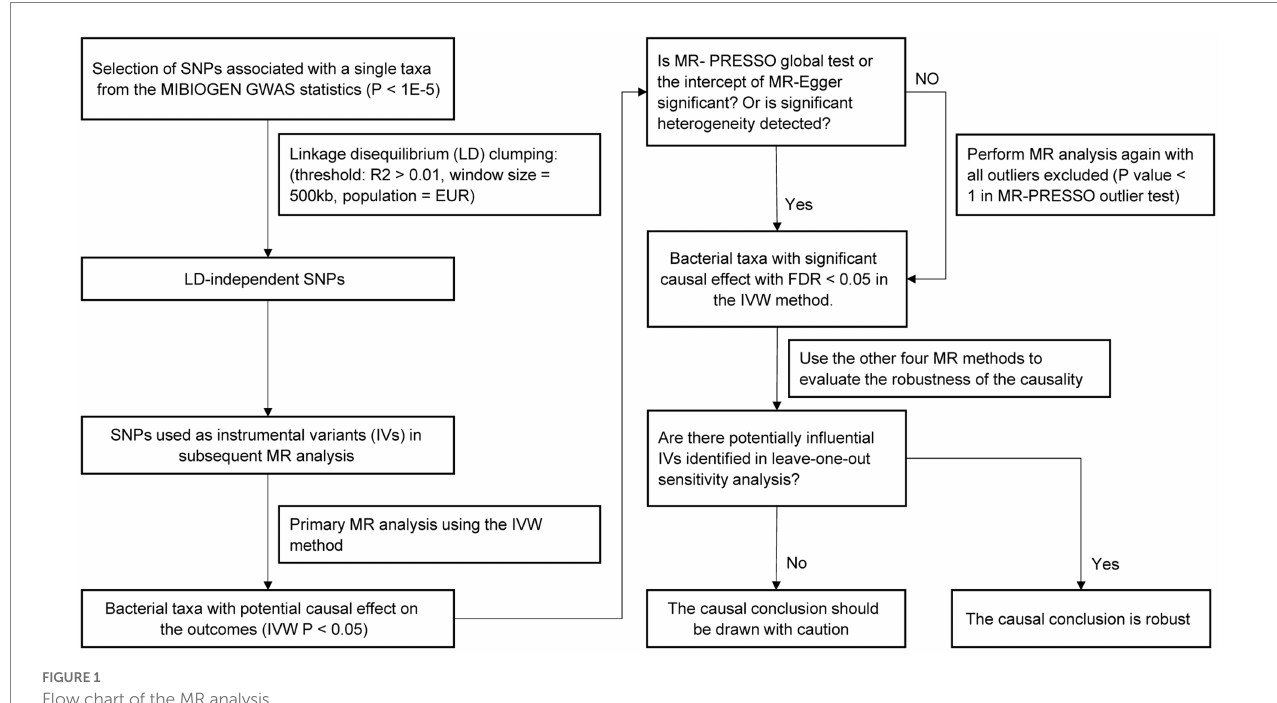
FIGURE 1 Flow chart of the MR analysis.